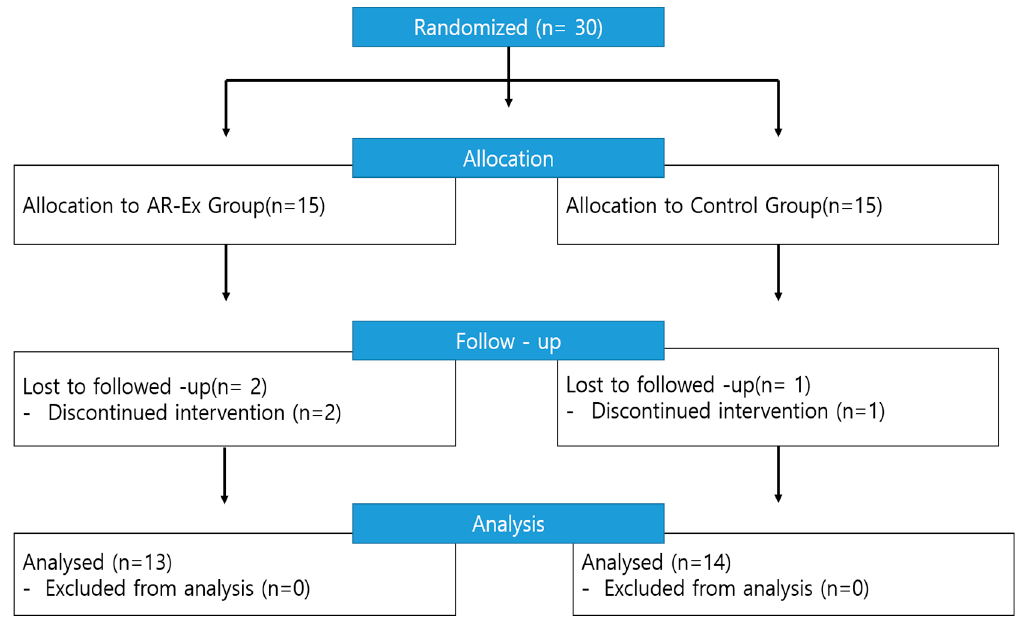
Figure 1. Participant allocation (consolidated standards for reporting of trials flow diagram).